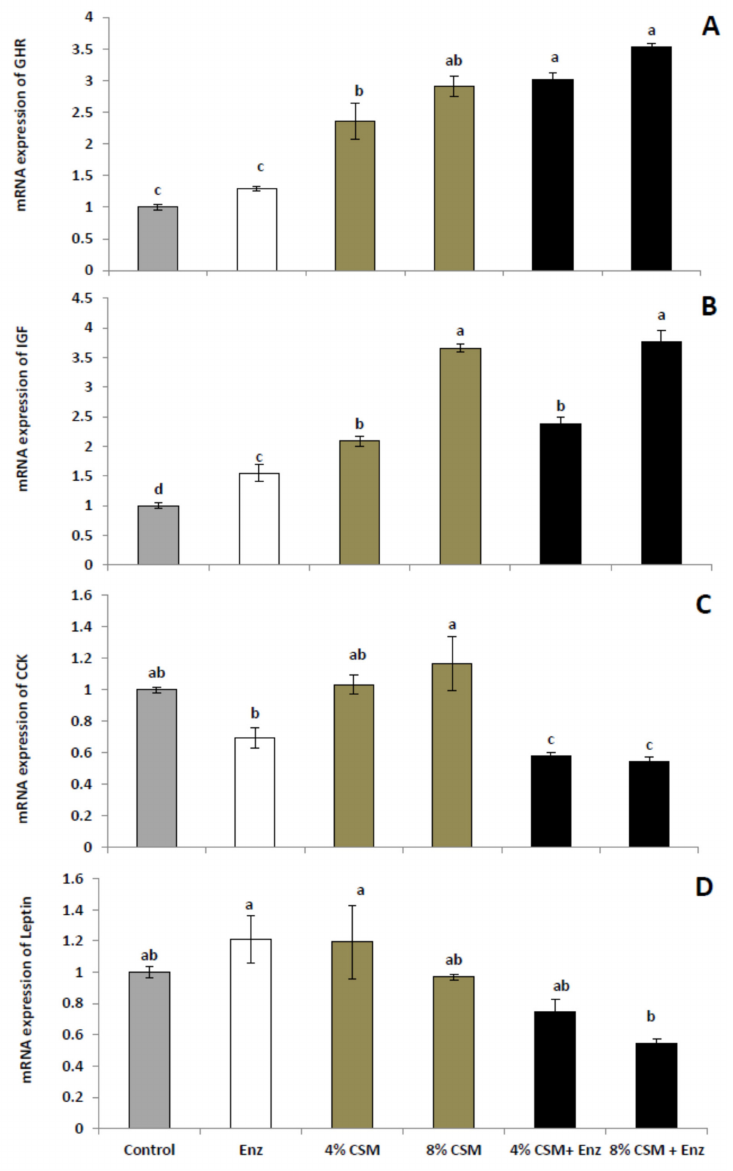
Figure 1. Effects of feeding corn silk meal and/or NSP enzyme mRNA of genes-related growth (Growth Hormone Receptor (GHR) ( A ), Insulin Like Growth Factor (IGF), ( B ) and feed intake regulatory genes (Cholecystokinin (CCK) ( C ) and Leptin ( D